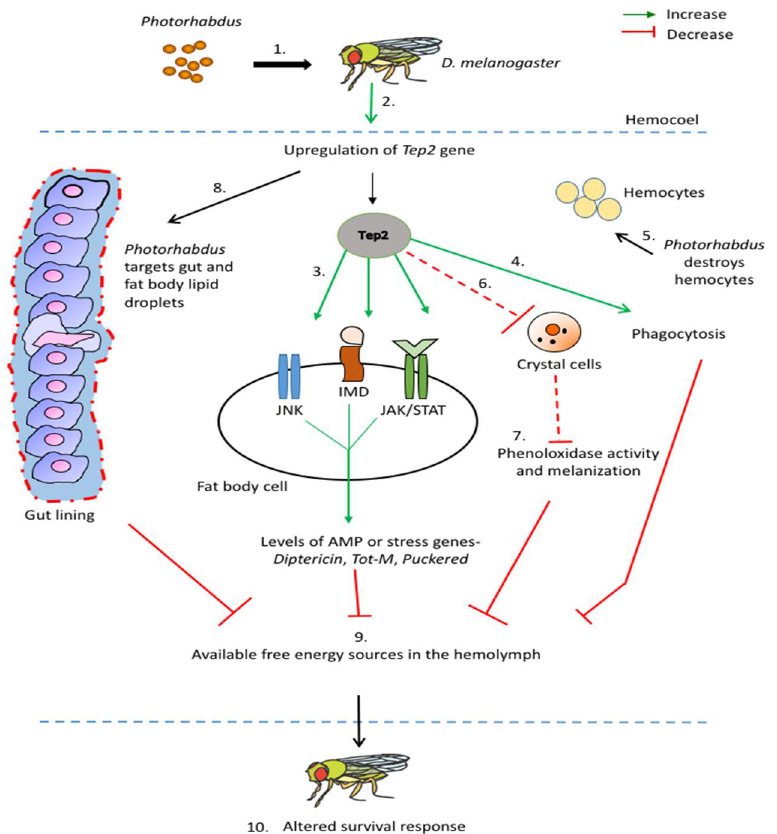
Figure 1. Model for the participation of TEP2 in the humoral and cellular immune response of Drosophila melanogaster wild-type adult flies against Photorhabdus entomopathogenic bacteria . 1. Photorhabdus enters the hemolymph of the flies. 2. Tep2 is upregulated in fly tissues such as fat body and hemocytes after Photorhabdus injection. 3. Upregulation of Tep2 results in the activation of Immune Deficiency (Imd), Janus kinase (Jak)/signal transducer and activator of transcription (Stat), and c-Jun-terminal kinase (Jnk) pathways leading to upregulation of antimicrobial peptide (AMP) and stress-related genes such as Diptericin , Turandot-M (Tot-M), and Puckered . 4. Upregulation of Tep2 increases phagocytosis in response to Photorhabdus infection. 5. Photorhabdus targets and kills hemocytes (specifically plasmatocytes). 6. Upregulation of Tep2 results in the appearance of fewer crystal cells in the hemolymph after Photorhabdus infection. 7. Reduced number of crystal cells leads to decreased phenoloxidase activity and melanization response. 8. Photorhabdus targets the gut (shown as red dashed border) and fat body lipid droplets promoting increased pathogen burden in the fly and consequently leading to increased cell death (activation of caspase Dronc). 9. The fly uses available energy sources (such as triglycerides and trehalose) to combat Photorhabdus infection. 10. The interaction between the Drosophila immune system activated through Tep2 and Photorhabdus pathogenicity strategies results in altered survival of the fly. Solid red lines denote inhibition and dashed red lines denote decrease.